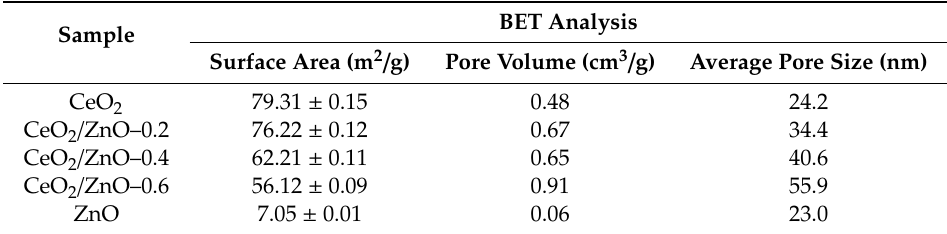
Table 1. Textural characteristics of bare CeO 2 , ZnO and the CeO 2 /ZnO samples.